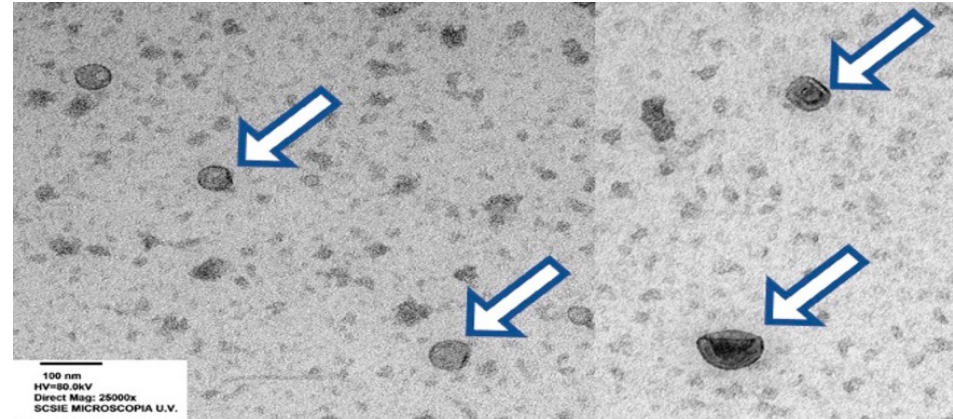
Figure 3. Transmission electron micrographs of extracellular vesicles (EVs, arrows) in porcine seminal plasma (bar: 100 nm), courtesy of Barranco et al. [39].